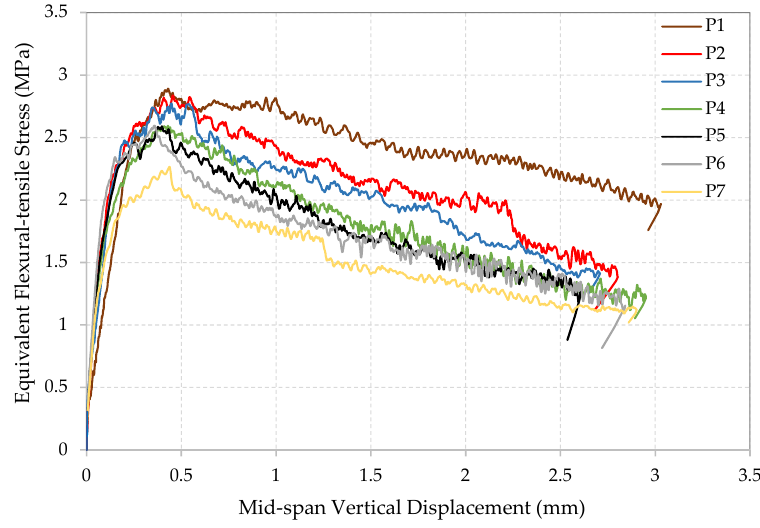
Figure 7. Equivalent Flexural-tensile stress vs. Mid-span Vertical Displacement. Table 3. Average Residual Flexural Strength Values and Coefficients of Variation per